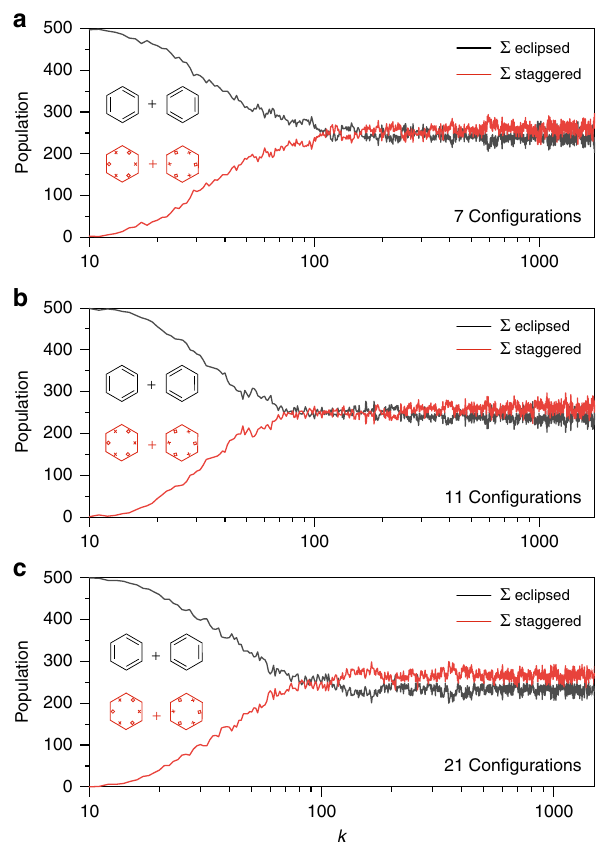
Fig. 3 Analysis of the (6,6) CAS-CI wavefunction by Metropolis sampling. The populations in the Voronoi cells, corresponding to eclipsed (black) and staggered (red) arrangements of the C – C bonding electrons, are plotted for three truncations of the (6,6) CAS-CI wavefunction sum, as a function of the Monte Carlo step number, k : a 7 con fi gurations, b 11 con fi gurations, c 21 con fi gurations.